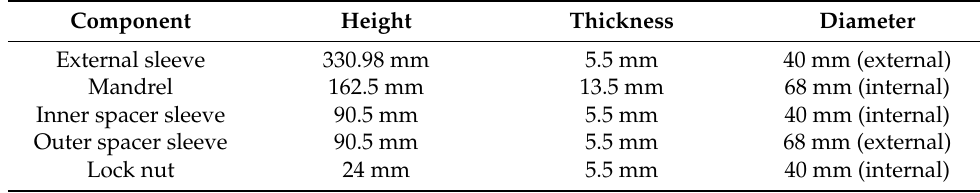
Figure 3. Mechanical spindle—BT30. Table 4. Parameters of mechanical spindle BT30 ′ s components.